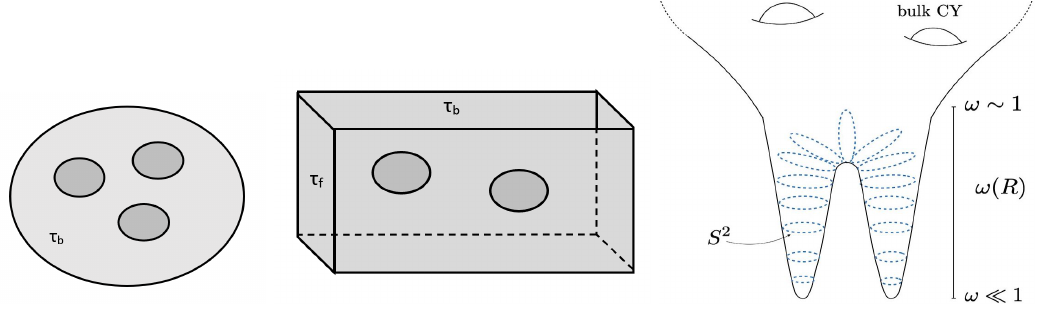
Figure 1 . Pictorial representation of Swiss-cheese (left), K3 fibred geometry (centre) and double- throats (right) in Calabi-Yau (CY)